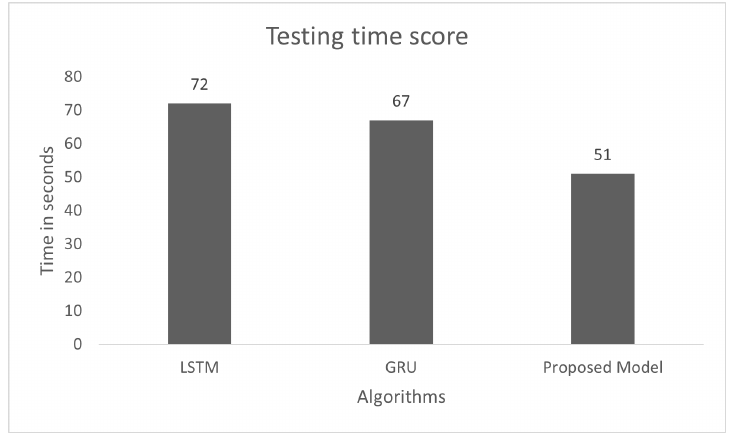
Figure 20. Testing time score on the car-hacking dataset.